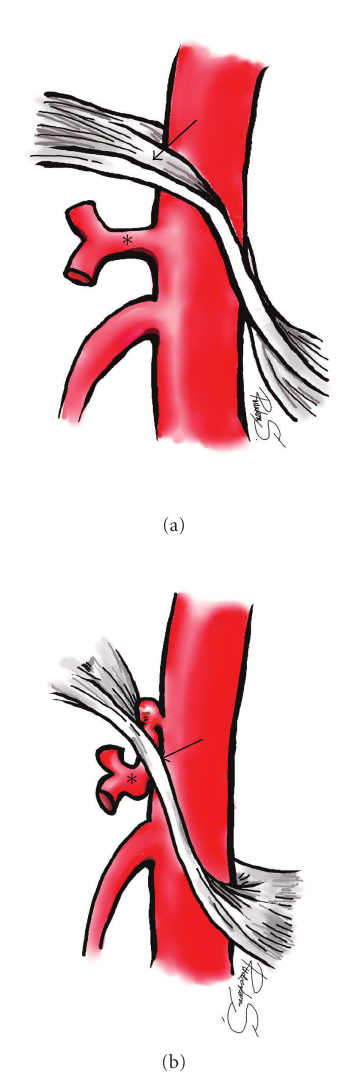
Figure 1: Drawing of sagittal view of normal anatomy of the median arcuate ligament (a), its normal course (arrow) passes anterior to the aorta and superior to the celiac artery (asterisk). In case of median arcuate ligament (b), the fibrous ligament (arrow) crosses proximal portion of the celiac artery (asterisk) resulting in compression.